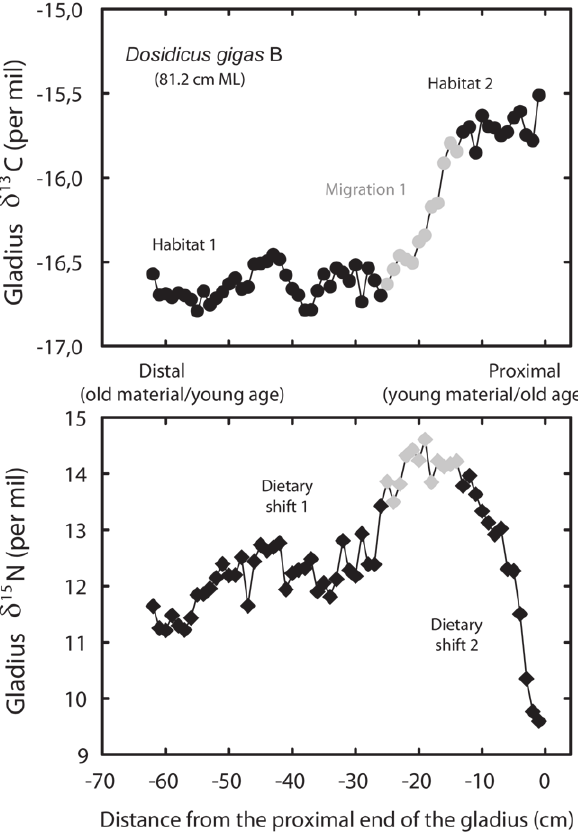
Figure 3. High resolution isotopic profile along individual B gladius. d 13 C (filled circles) and d 15 N (filled diamonds) values along the length of the gladius of a 81.2 cm ML jumbo squid. Grey symbols represent period of migration, while black symbols illustrate a more fixed isotopic habitat.